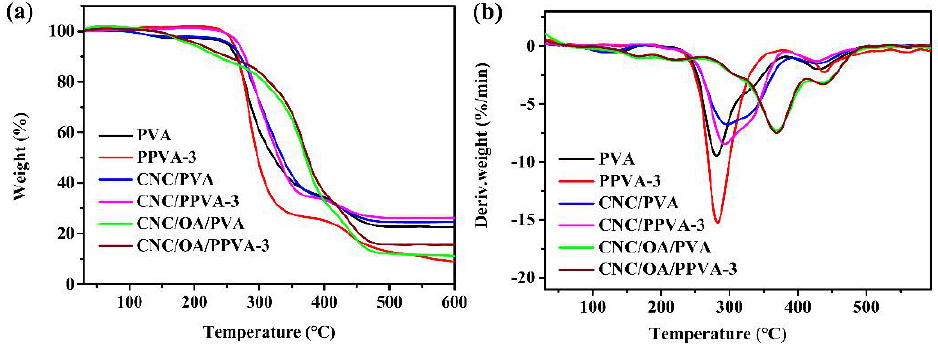
Figure 8. TGA ( a ) and DTG ( b ) thermographs of different films before and after air plasma trea ‒ ment.